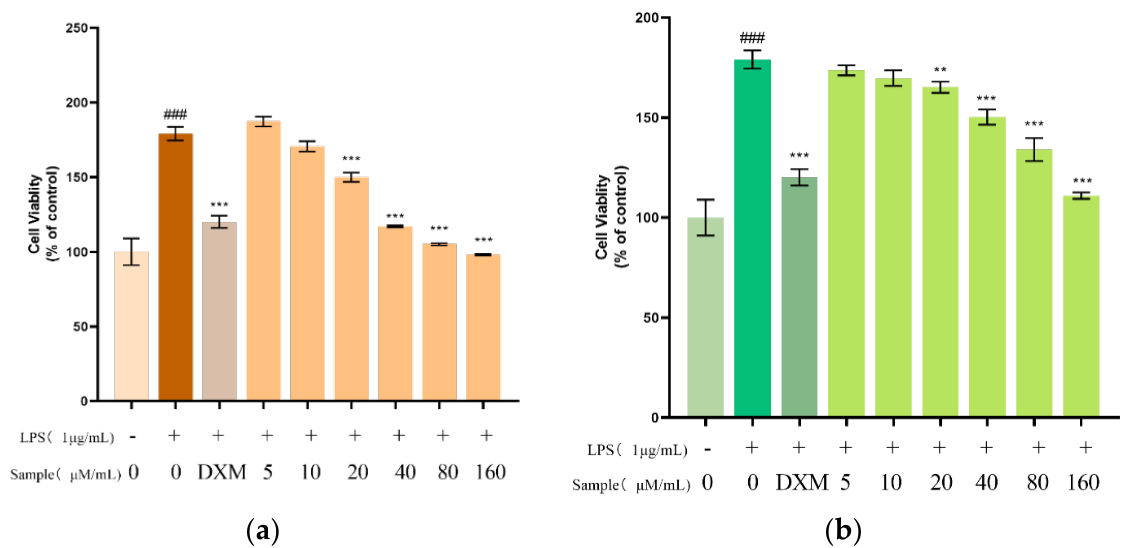
Figure 4. The effects of Ardisicreolides A ( a ) and B ( b ) on the cell viability of LPS-treated RAW264.7 cells. The data were expressed as the mean ± SD ( n = 3). ** p < 0.01, *** p < 0.001 versus the control cells that were treated with LPS. ### p < 0.001 versus the control group.